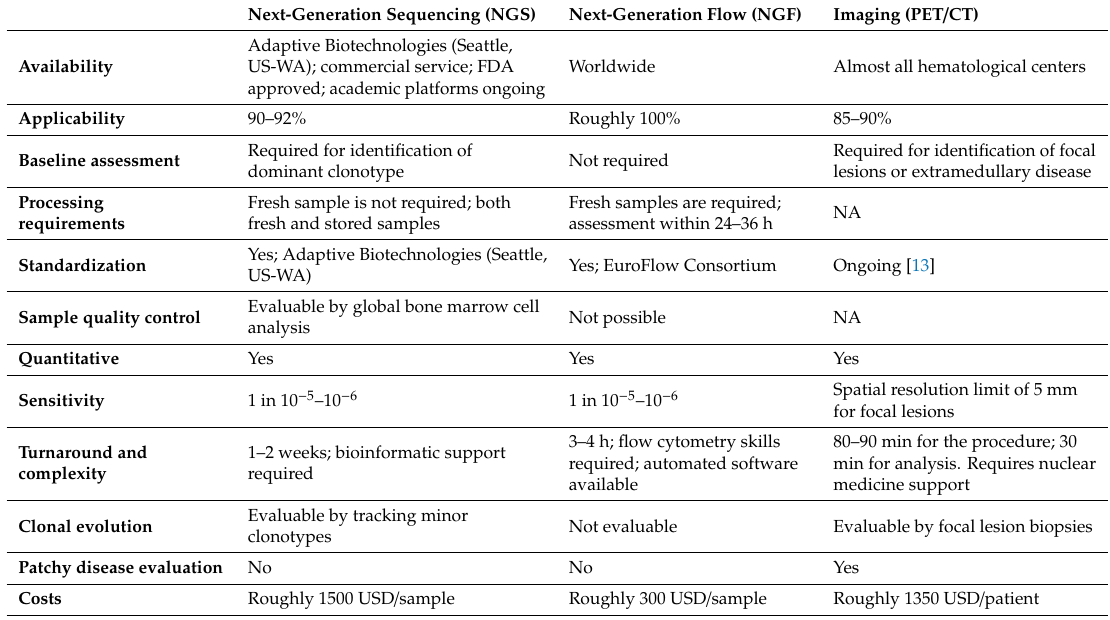
Table 1. MRD techniques for myeloma recommended by the IMWG [12]: pros and